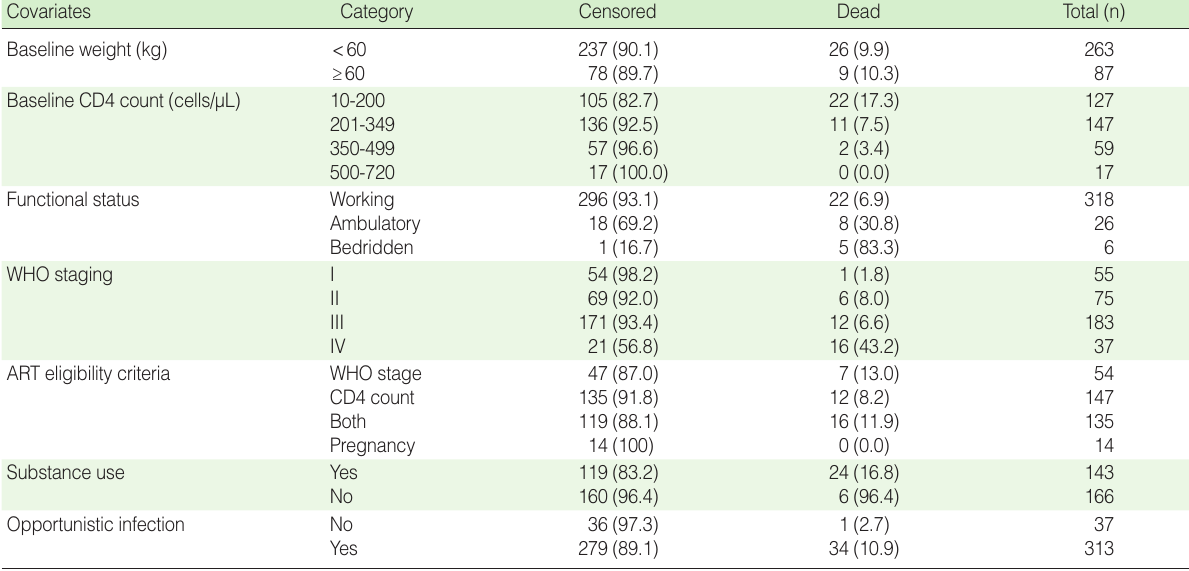
Table 2. Baseline clinical and laboratory information of HIV patients receiving ART at Jinka Zonal Hospital, Jinka, South Omo, Ethiopia in 2016 (n=350)